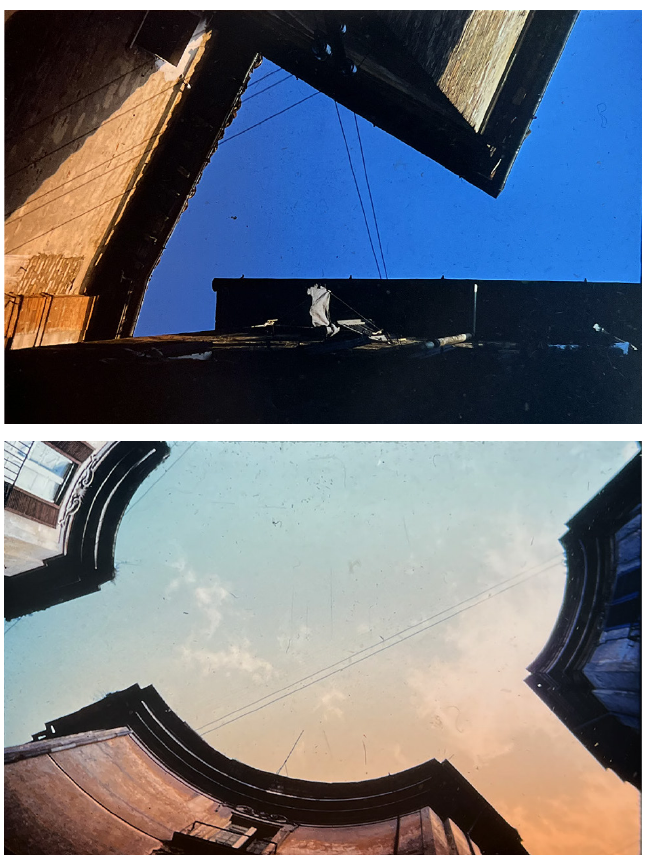
Fig. 7 Color slides from photographs taken by Robert Venturi. Views from bottom to